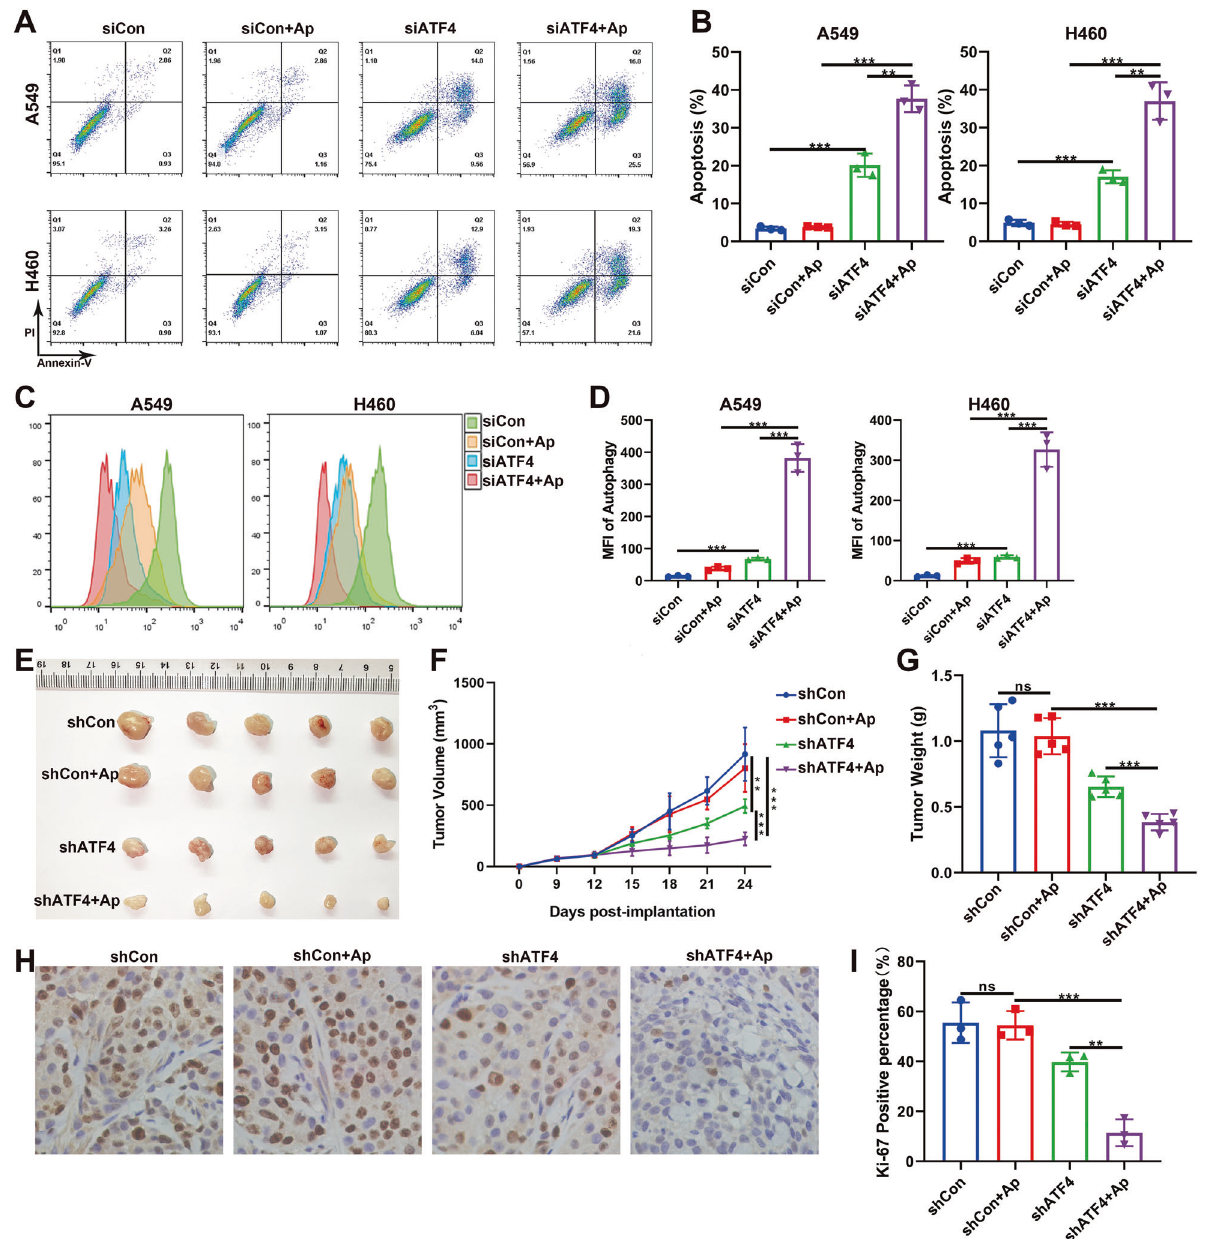
Fig. 6 Combination of apatinib and ATF4 silencing contributed to cancer inhibition in vitro and in vivo. A , B A549 and H460 cells were treated with or without siATF4 or apatinib, and fl ow cytometry was performed to detect apoptotic cells. C , D A549 and H460 cells were treated with or without siATF4 or apatinib, and a Cyto-ID detection assay was performed to evaluate the autophagy level. E Mouse xenograft tumors were established using shCon-H460 cells or shATF4-H460 cells. After treatment with apatinib or saline, the xenograft tumors were harvested and the images were photographed. F Tumor volumes were scaled every 3 days, and tumor growth curves were drawn. G Weights of the xenograft tumors. H , I Representative IHC images and analysis of positive percentage of Ki-67 expression in xenograft tumors. Data are presented as mean ± SEM from three independent